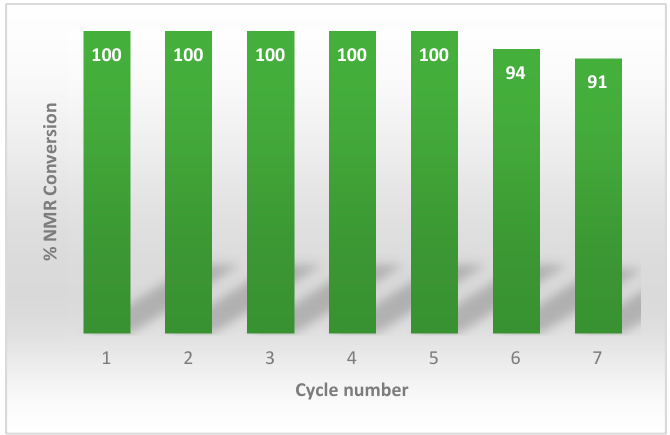
Figure 1. NMR conversion in the first seven reuses of the aqueous phase in the Se-conjugate addition of diphenyl diselenide 1 to cyclohexenone 21 .